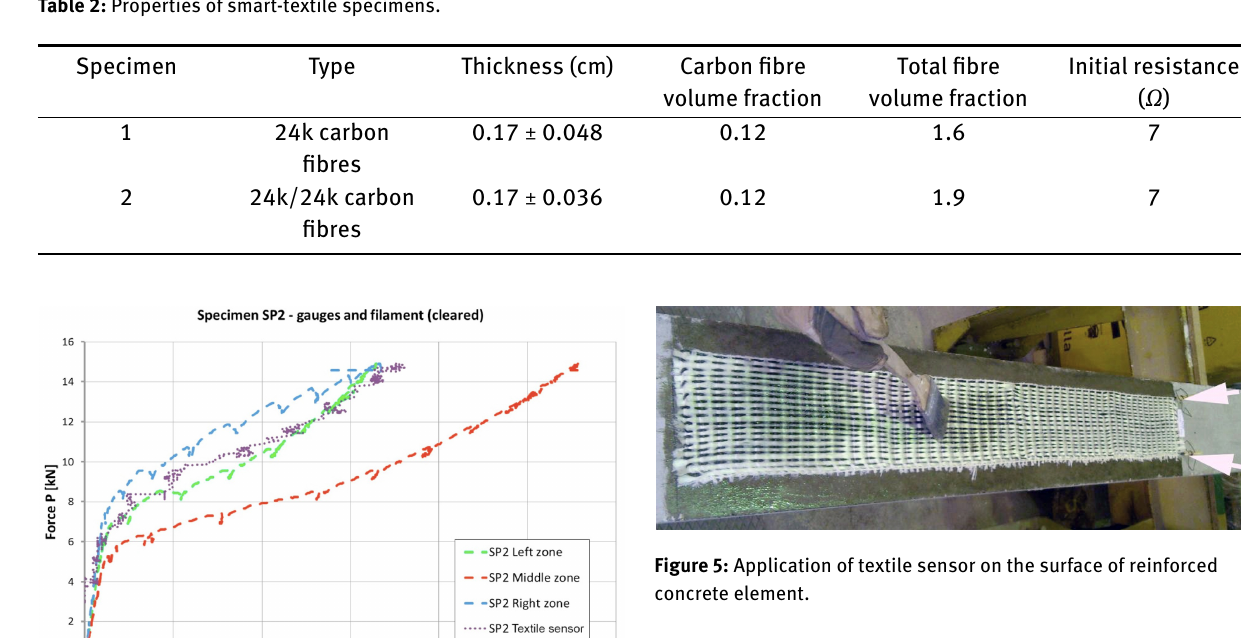
Table 2: Properties of smart-textile specimens.